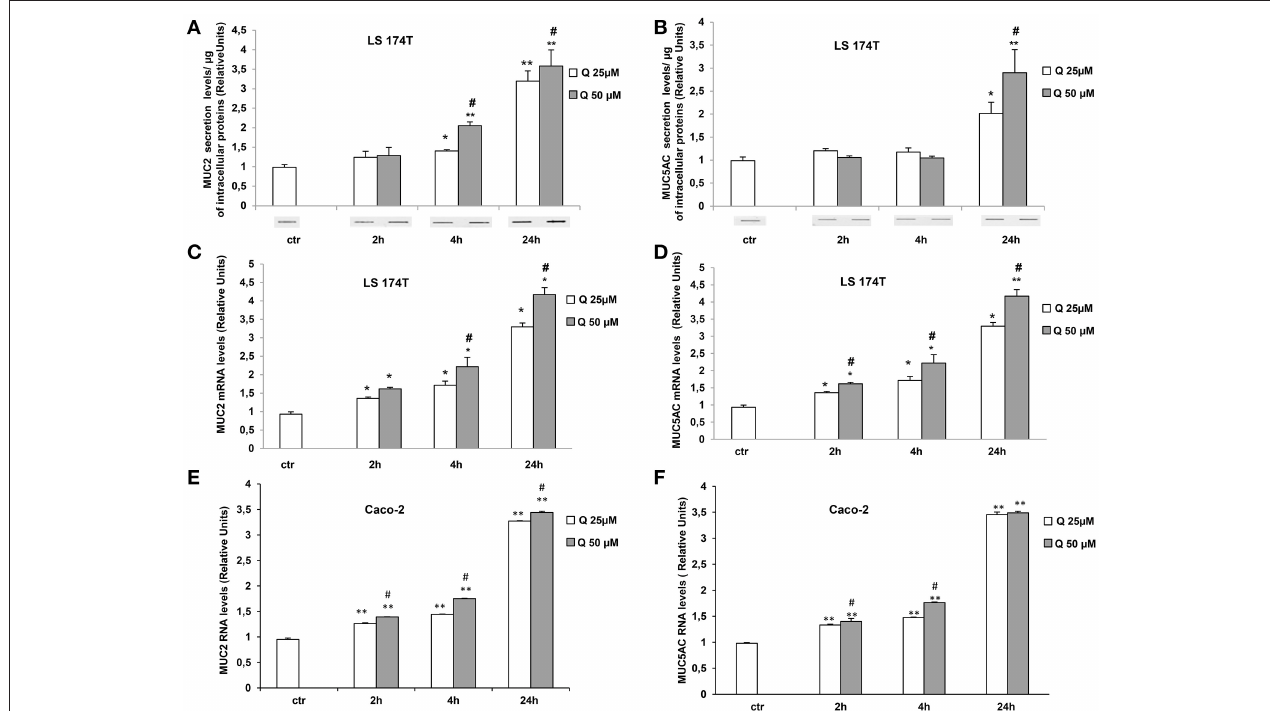
FIGURE 2 | Quercetin increases MUC2 and MUC5AC secretion and mRNA levels. (A,B) Slot-Blot analysis of LS174T cell medium. Cells were incubated with MEM medium without FBS for 24h and stimulated with 25 (Q25) or 50 (Q50) µ M quercetin at the indicated times. The histogram shows the mean ± SE ( n = 3) values of MUC2 (A) and MUC5AC (B) levels obtained by densitometric analysis of protein bands and normalized to the respective intracellular protein concentrations of three independent experiments. * p < 0.05 and ** p < 0.001 vs. Ctr, # p < 0.05 vs. 25 µ M of the corresponding time point. Real-time-PCR analysis of MUC2 and MUC5AC m-RNA levels in LS174T (C,D) and in Caco-2 (E,F) cells treated at the times indicated with 25 and 50 µ M quercetin in medium without serum. Expression values were normalized using glucose-6-phosphate-dehydrogenase mRNA(G6PD) The histogram shows the mean ± SE ( n = 3) of RT-PCR of three independent experiments. * p < 0.05 and ** p < 0.001 vs. Ctr, # p < 0.05 vs. 25 µ M of the corresponding time point.